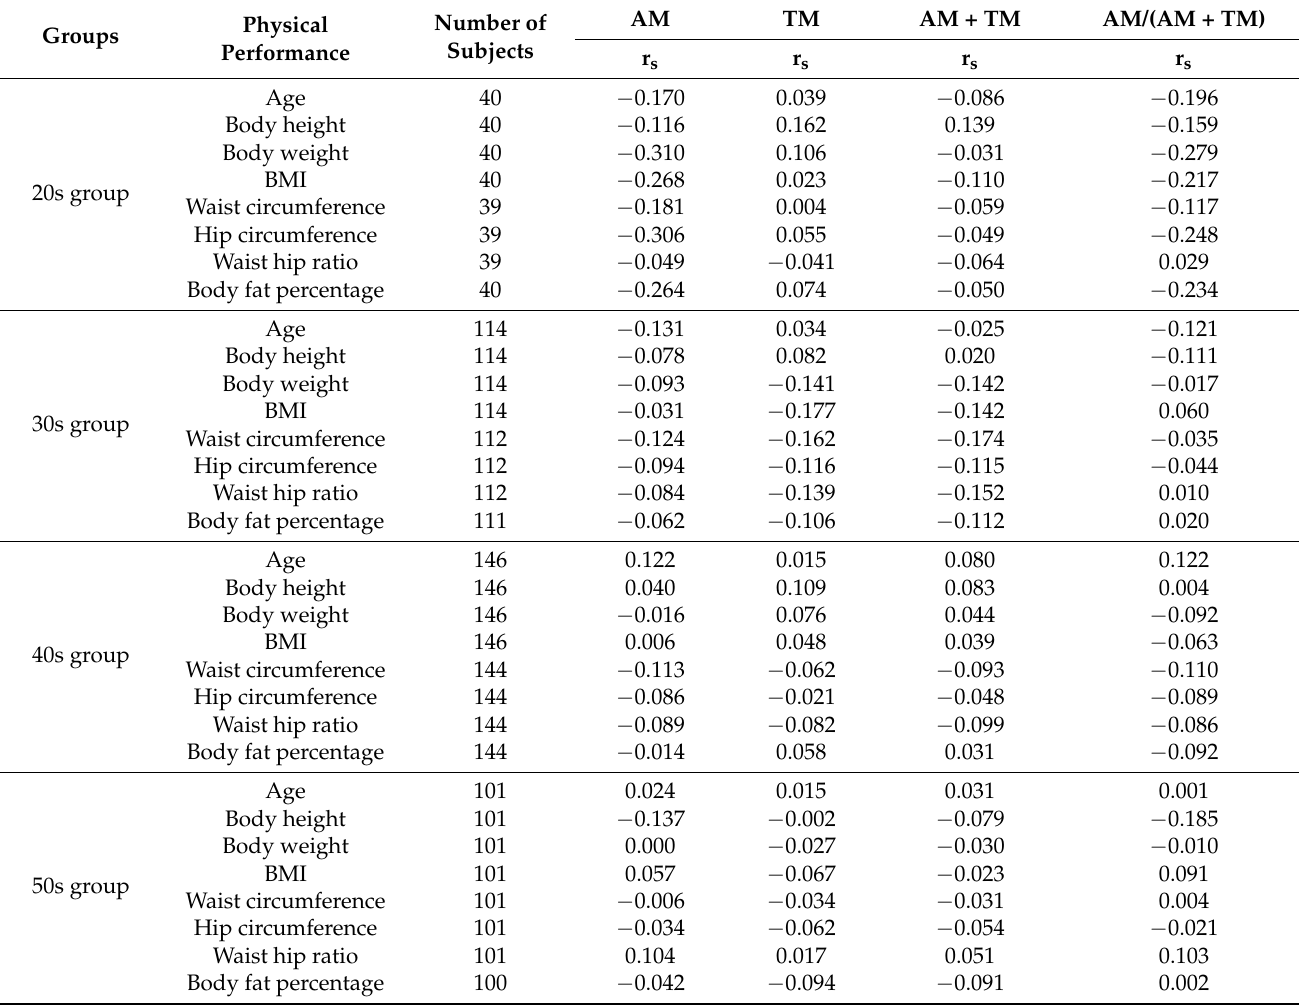
Table 3. Correlation between respiratory movements and age, body size, and body fat